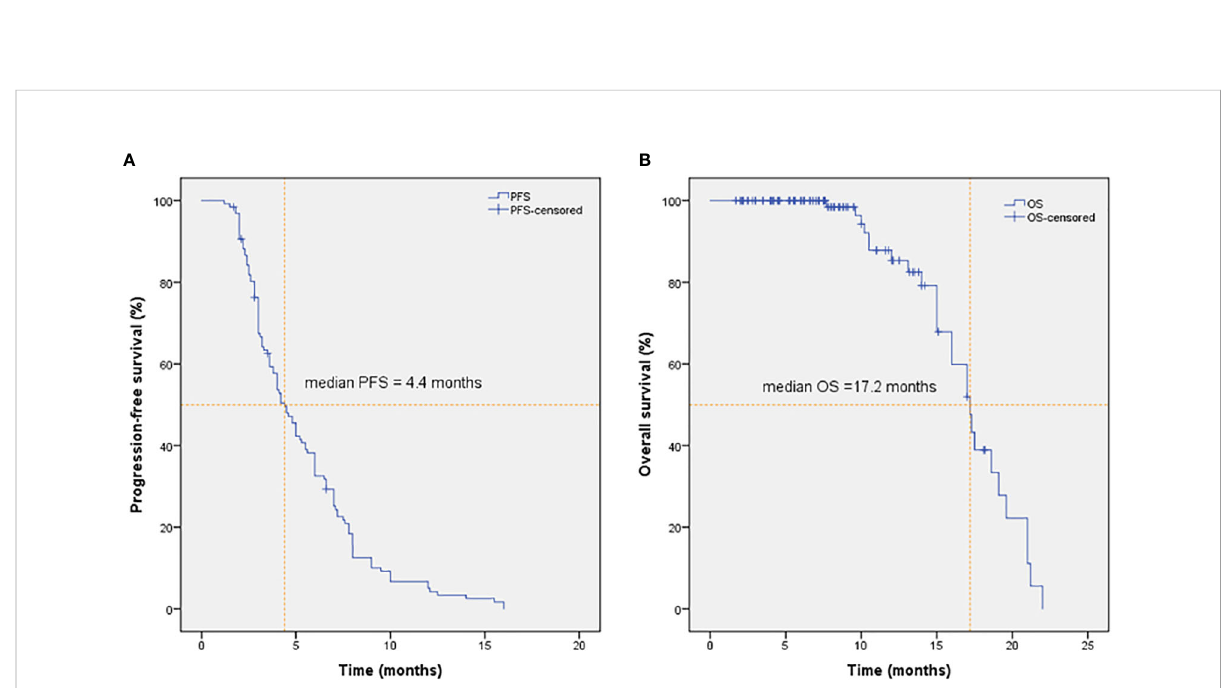
FIGURE 2 PFS (A) and OS (B) of patients in NSCLC treated with Apatinib. The mPFS and mOS were 4.4 months and 17.2 months in NSCLC treated with Apatinib,